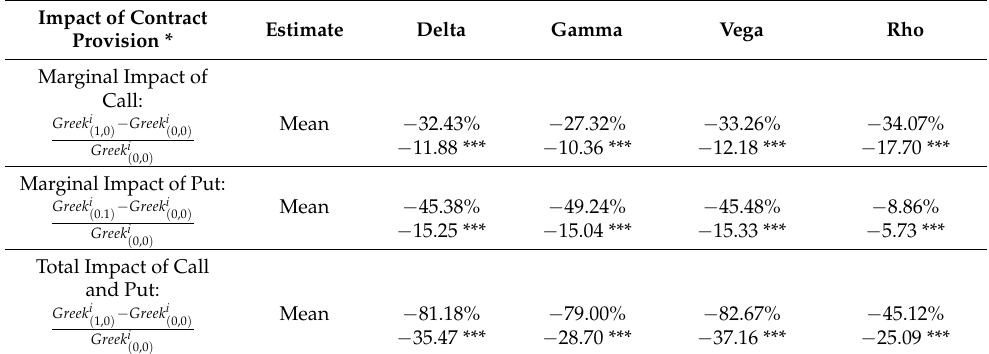
Table 4. Individual-security sensitivity of the Greeks to the call and/or put